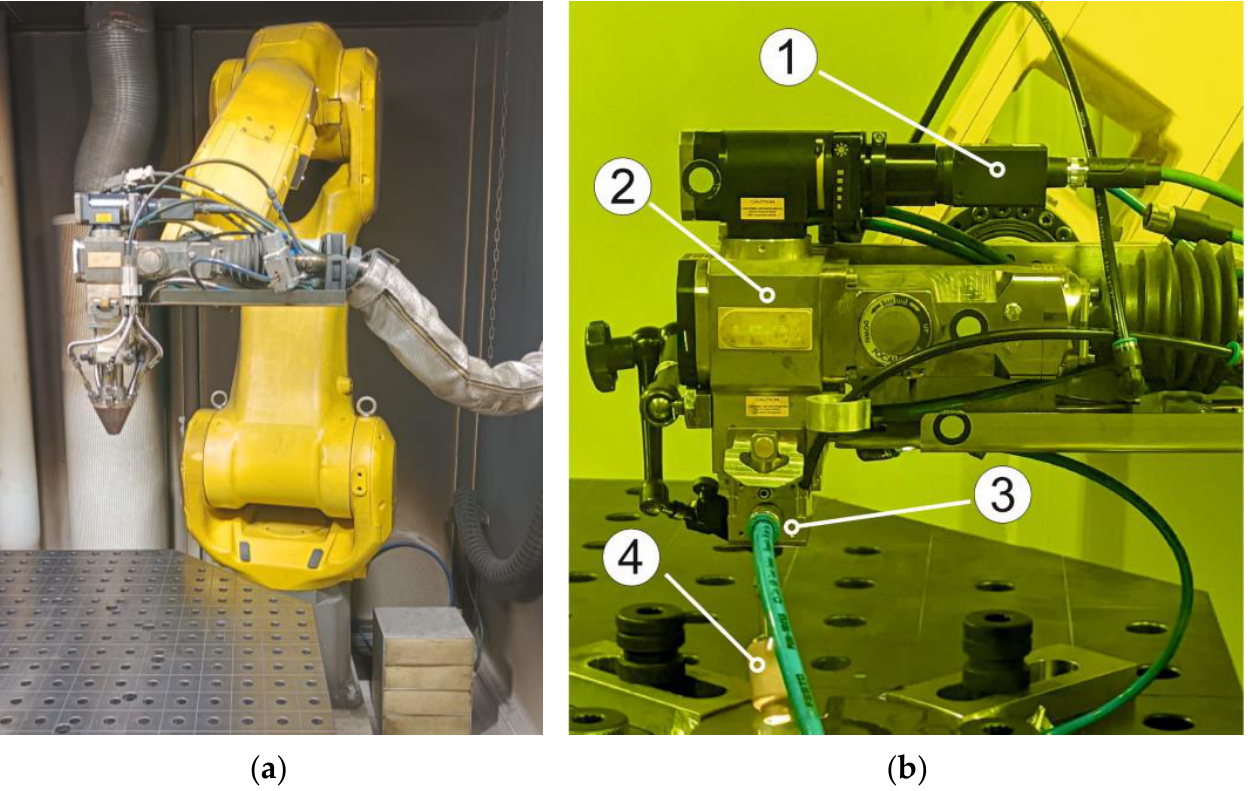
Figure 6. DLD complex: ( a ) with filler powder nozzle, ( b ) without filler powder nozzle. 1 — coaxial camera, 2 — laser head, 3 — cross-jet, 4 — shielding gas nozzle.